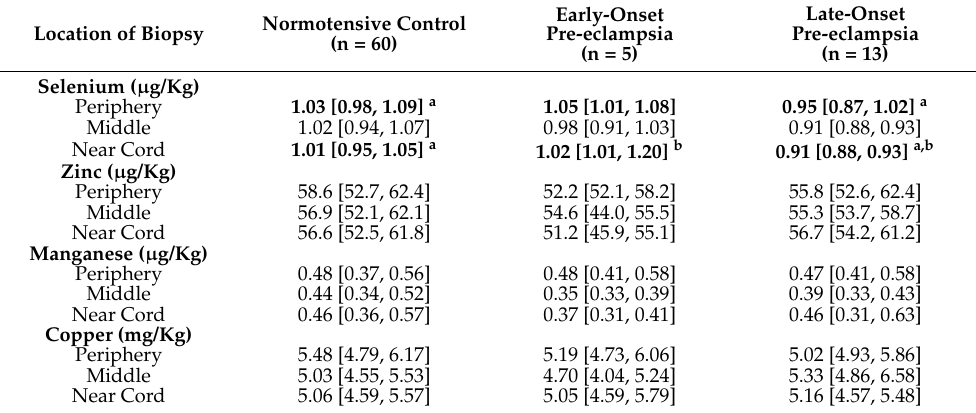
Table 2. Placental micronutrient concentrations *. Location of